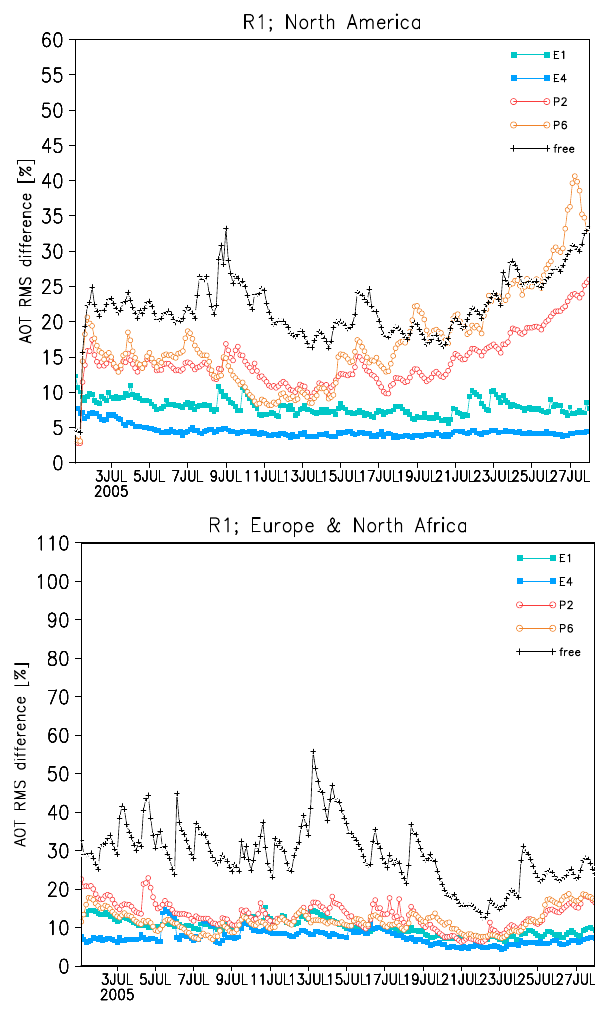
Fig. 4. Area-averaged differences [%] in AOT, for n reg = 1 experiments. The R1E2P4 experiment is used as the reference. The coloured lines refer to experiments for various ensemble sizes (E) and patch sizes (P). Notice how the assimilation converges as ensemble size increases. Also notice this is not the case for patch size, which has overall a bigger effect on the results.